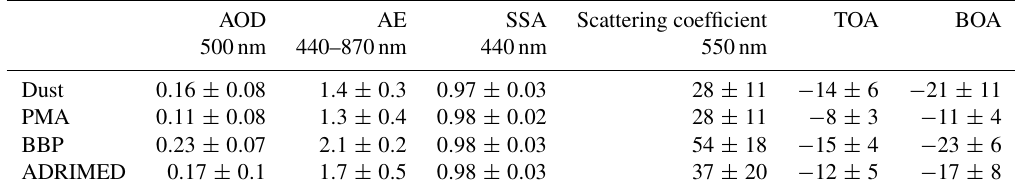
Table 4. Summary of the optical properties (mean and standard deviation) estimated for the three different aerosols regimes: AOD, AE, SSA, scattering coefficient (in Mm − 1 ), and instantaneous TOA and BOA radiative effect (inWm − 2 ) AOD AE SSA Scattering coefficient TOA BOA 500nm 440–870nm 440nm